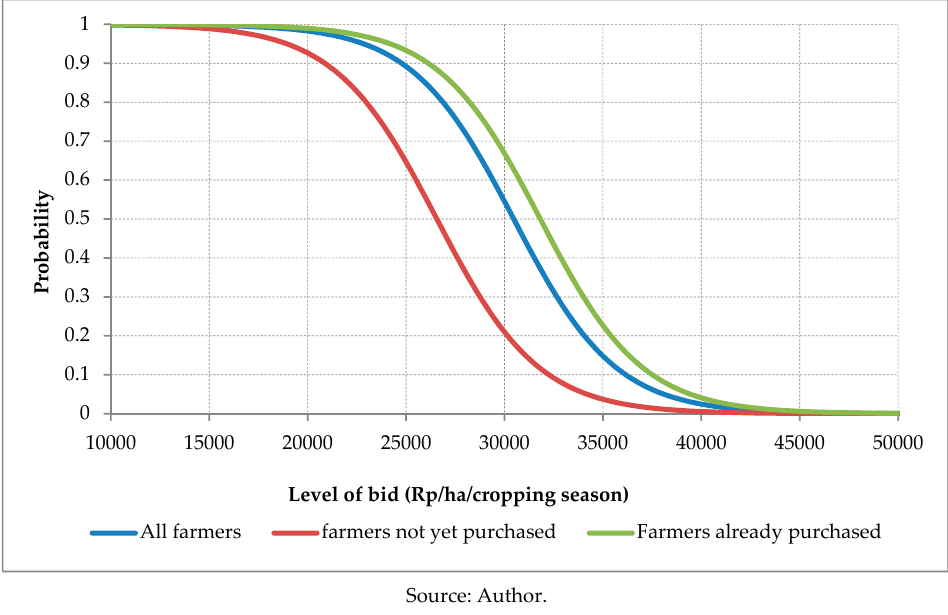
Figure 5. WTP of farmers who had already purchased and not yet purchased. Table 8. Mean value of WTP by location (farmers).